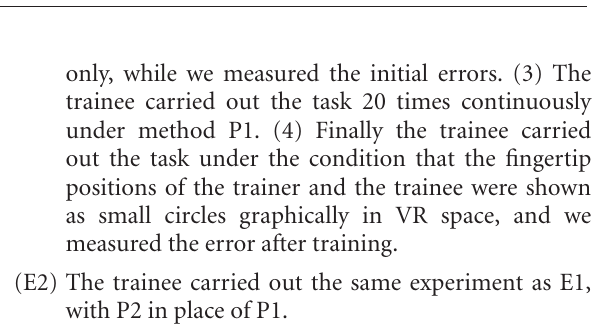
Table 3: The sequence of experiments E1 and E2. Order of experiment Group A Group B 1 E1 E2 2